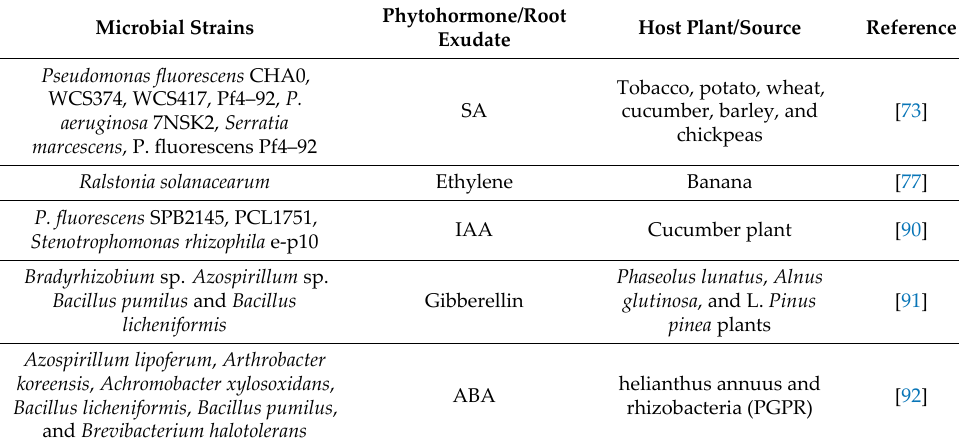
Table 1. List of microbes that produce